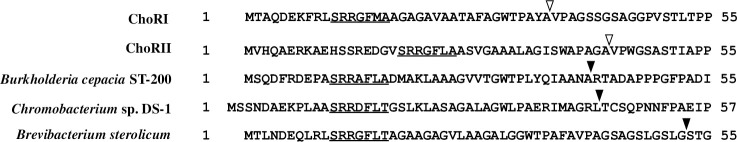
N-terminal amino acid sequences of VAO family cholesterol oxidases.These sequences include enzymes from ChoRI, ChoRII, Burkholderia cepacia ST-200 (accession no. BAB63263.1), Chromobacterium sp. DS-1 (no. BAG70948.1), and Brevibacterium sterolicum (no. Q7SID9). Putative consensus twin-arginine motifs are underlined. The open arrowheads indicate the presumptive cleavage sites of ChoRI and ChoRII. The filled arrowheads indicate the reported cleavage sites of the enzymes.